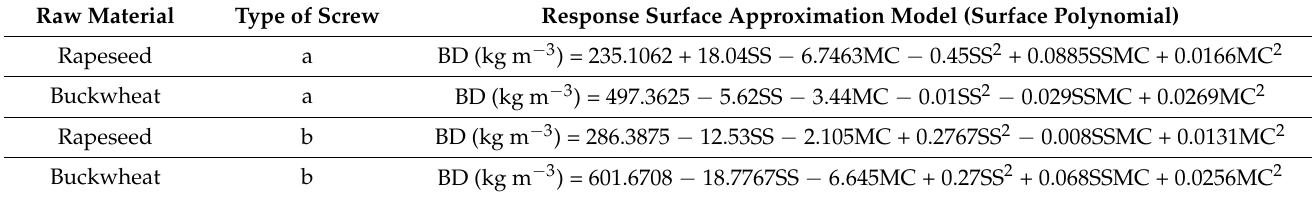
Table 5. Models of response surface approximation for the bulk density of extruded rapeseed and buckwheat straws depending on the process